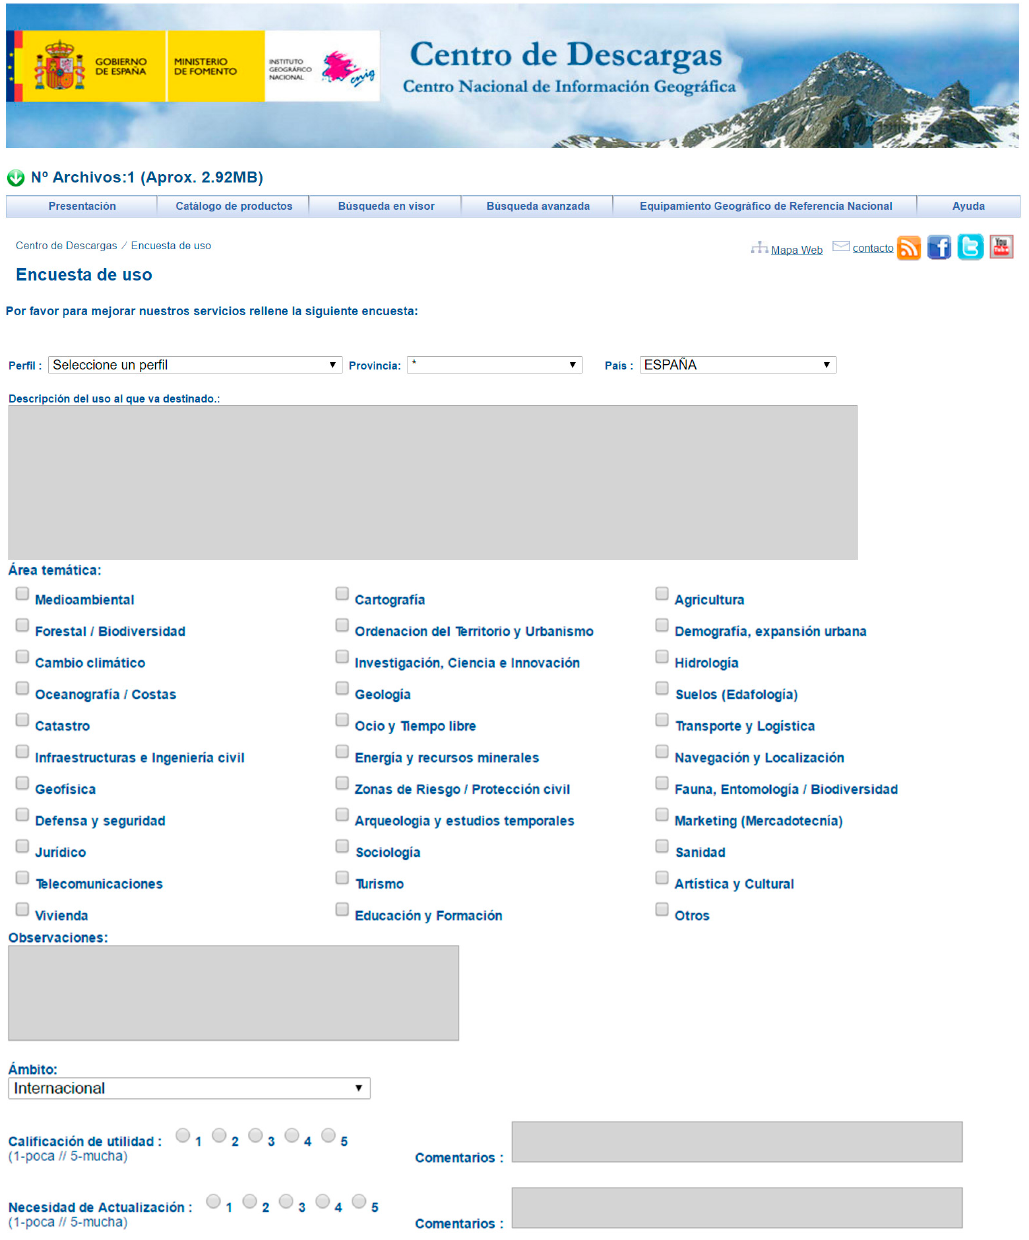
Figure 1. Web survey template of the Download Center (CNIG).